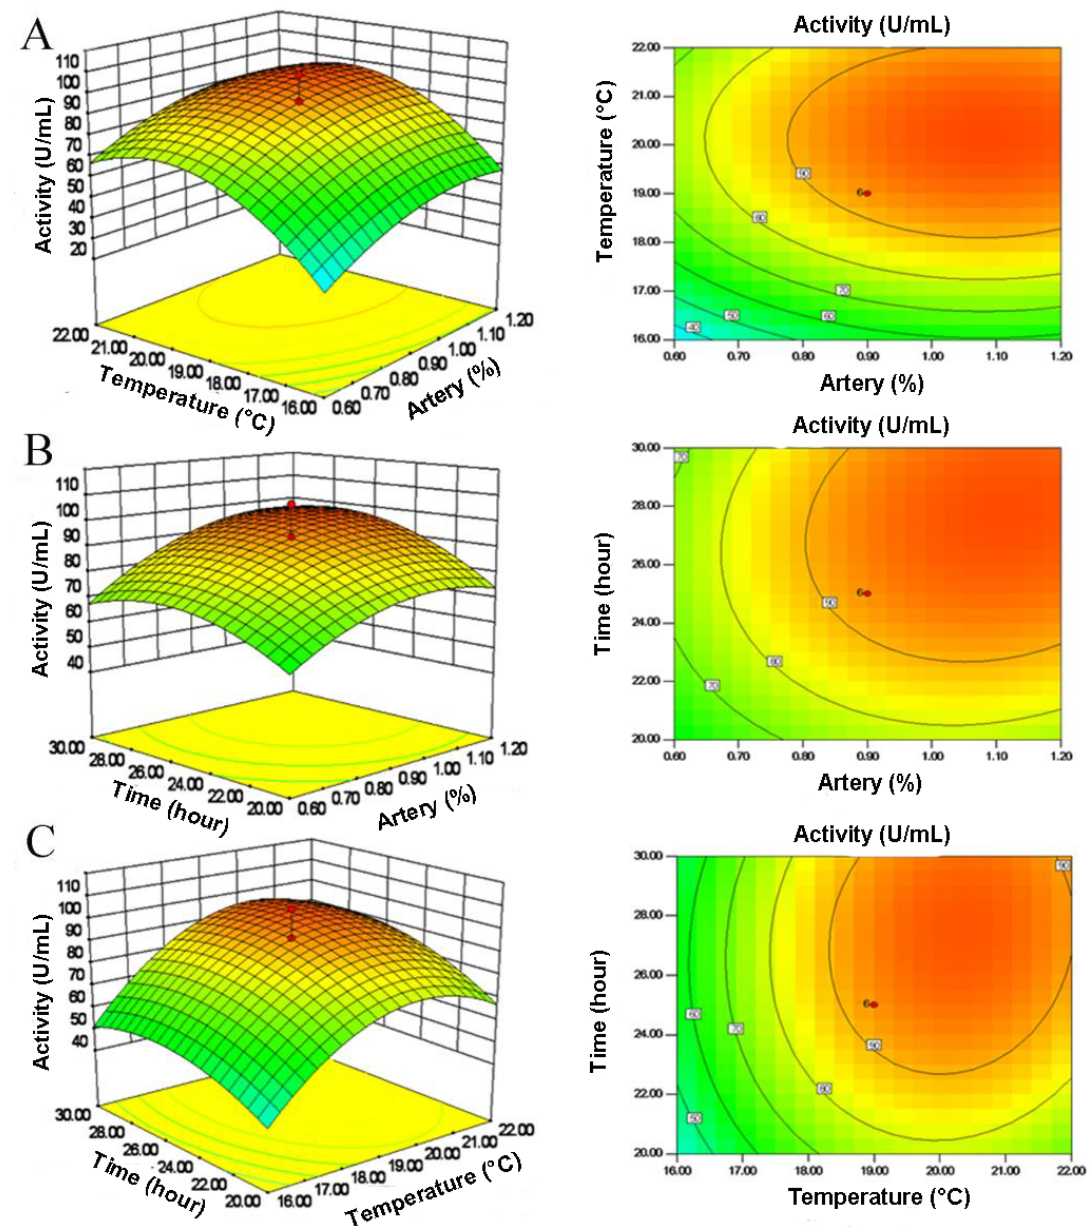
almost equal to the predicted value (101.385 U/mL). The excellent agreement between the predicted and measured values indicates the model validation and existence of an optimal point. Figure 2. Three-dimensional plots (left) and corresponding contour plots (right) of the effect of three variables on pseudoalterin production. When the effect of two variables was plotted, the other variable was set at the central level. ( A ) interaction between artery and culture temperature; ( B ) interaction between artery and culture time; ( C ) interaction between culture temperature and culture